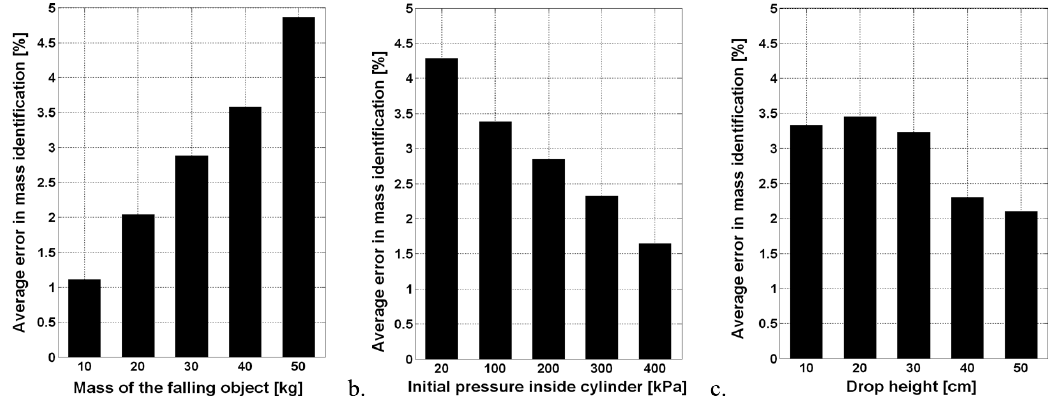
Fig. 12. Average error of mass identi fi cation in dependence on: a. falling mass; b. initial pressure; c. impact velocity.